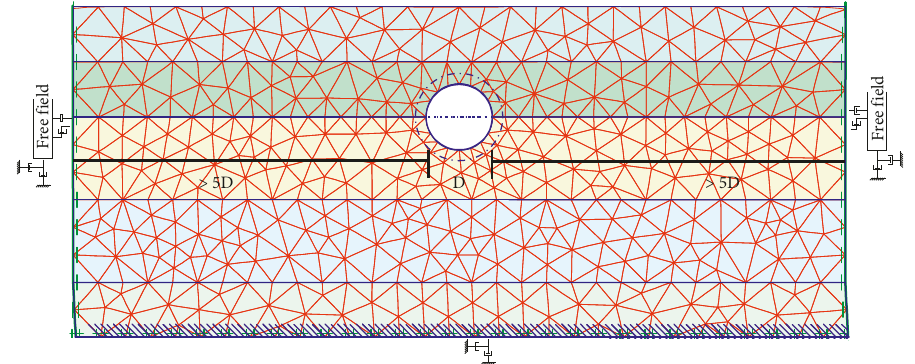
Figure 1: Schematic illustration of boundary conditions and dimensions of the